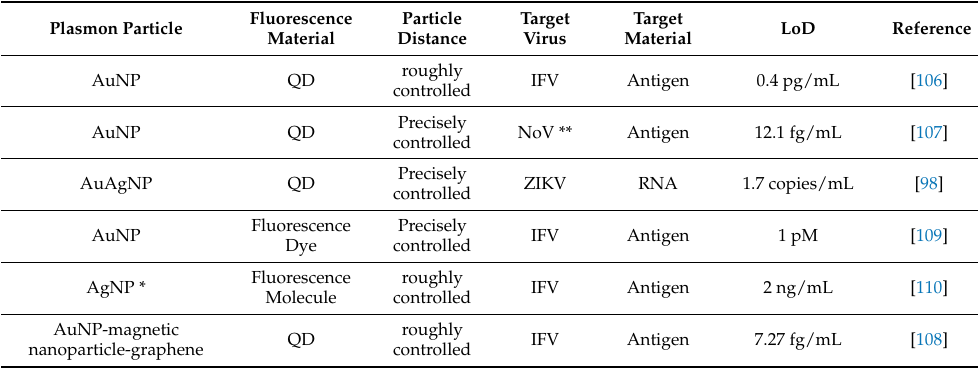
Table 2. Comparison of sensitivity of techniques applying the fluorescence enhancement effect of LSPR of plasmonic particles to virus